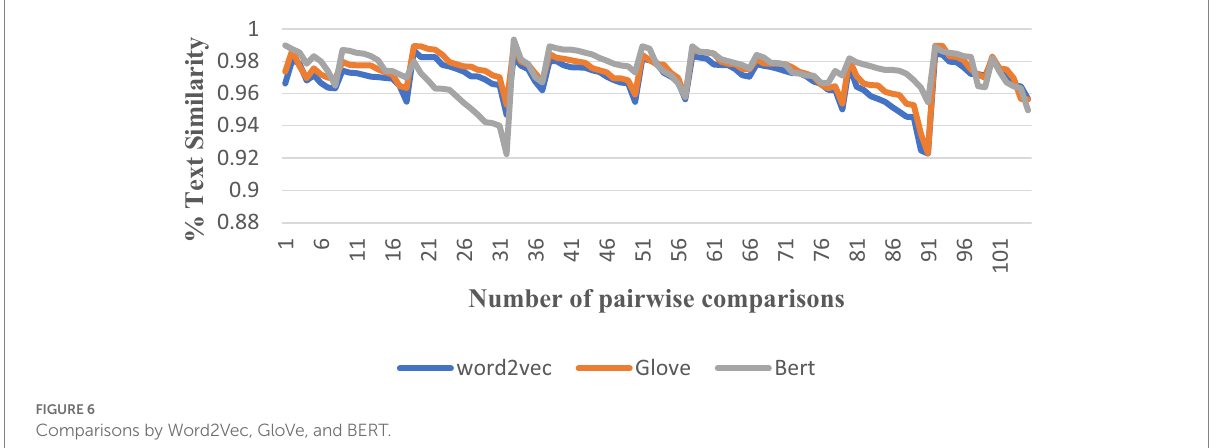
FIGURE 6 Comparisons by Word2Vec, GloVe, and